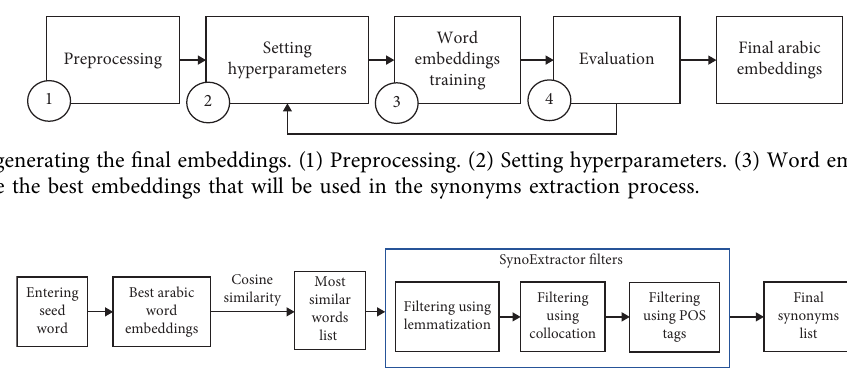
Figure 2: SynoExtractor pipeline: it starts with finding most similar words using cosine similarity for a set of seed words; then, the list of the most similar words are filtered using SynoExtractor filters to have the final synonyms list. Table 3: Sample of the collocation dictionary.